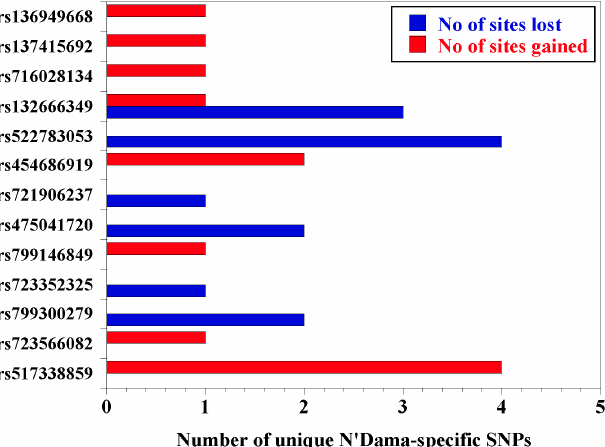
Figure 4. Effect of identified N’Dama-specific single nucleotide polymorphisms on transcription factor binding sites.